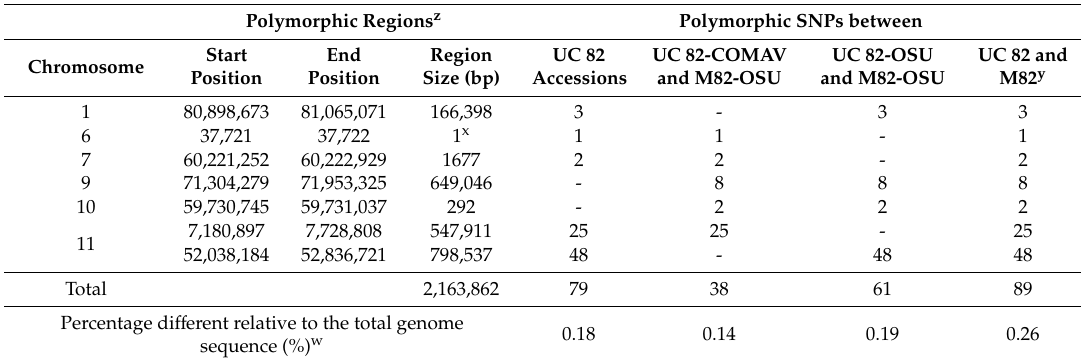
Table 1. Genomic regions carrying polymorphic Single Nucleotide Polymorphisms (SNPs) between ‘UC 82’ and ‘M82’ accessions based on the SolCAP Illumina array data.